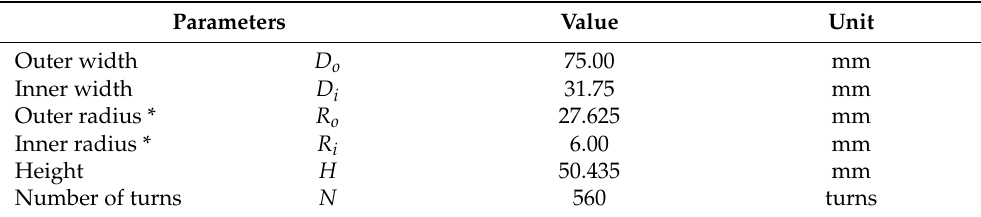
Table 1. Simulation (I): magnetic flux density comparison between square and cylindrical